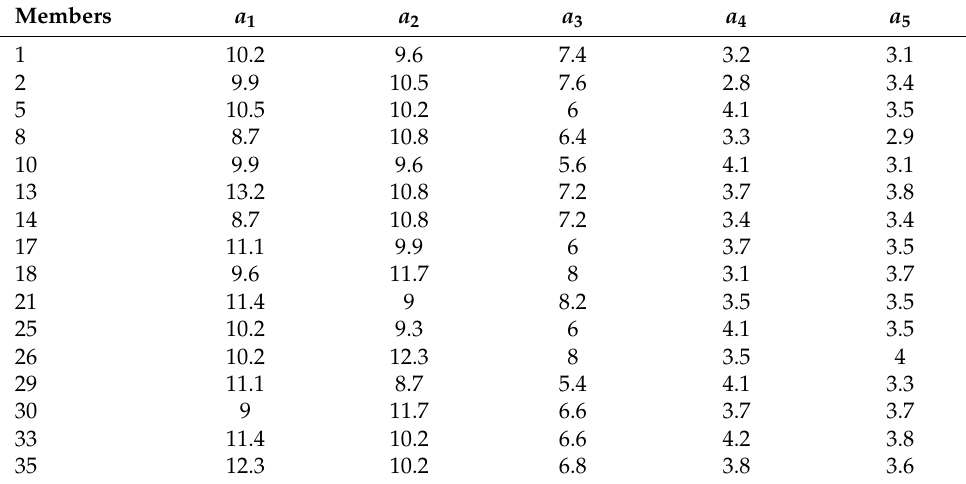
Table 4. Utility ability values of alternative members after refinement.